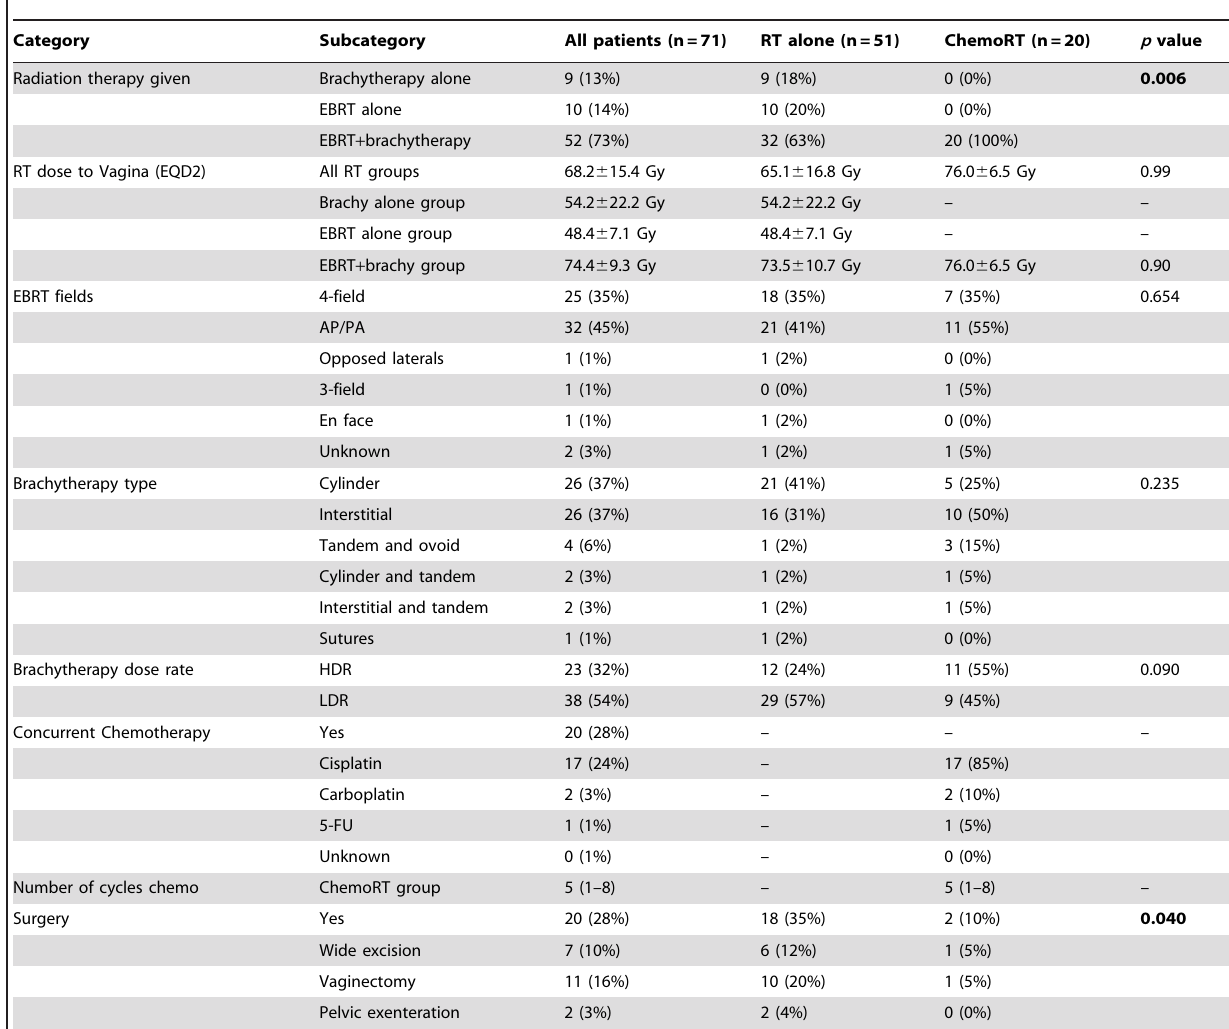
Table 2. Treatment